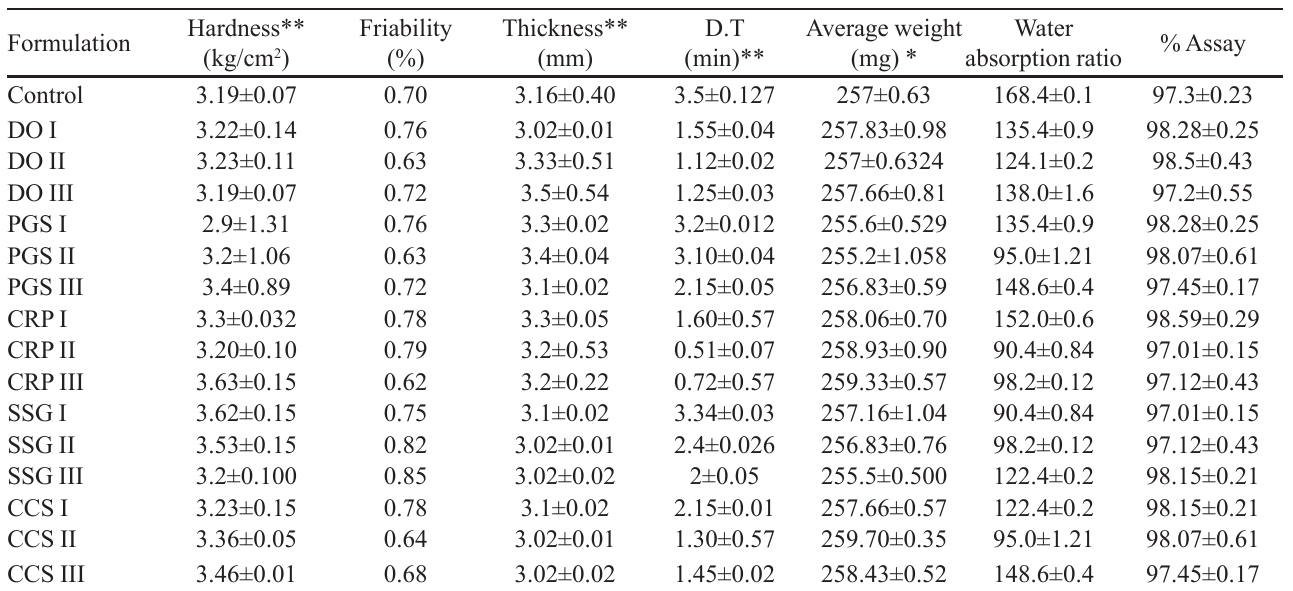
TABLE VII - Evaluation of fast-dissolving tablets